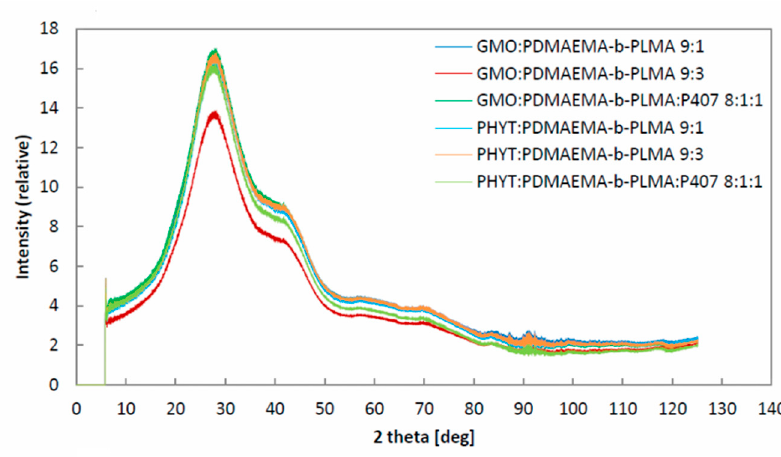
Figure 7. X-ray di ff ractograms of the prepared nanosystems. Figure 7. X-ray diffractograms of the prepared nanosystems.